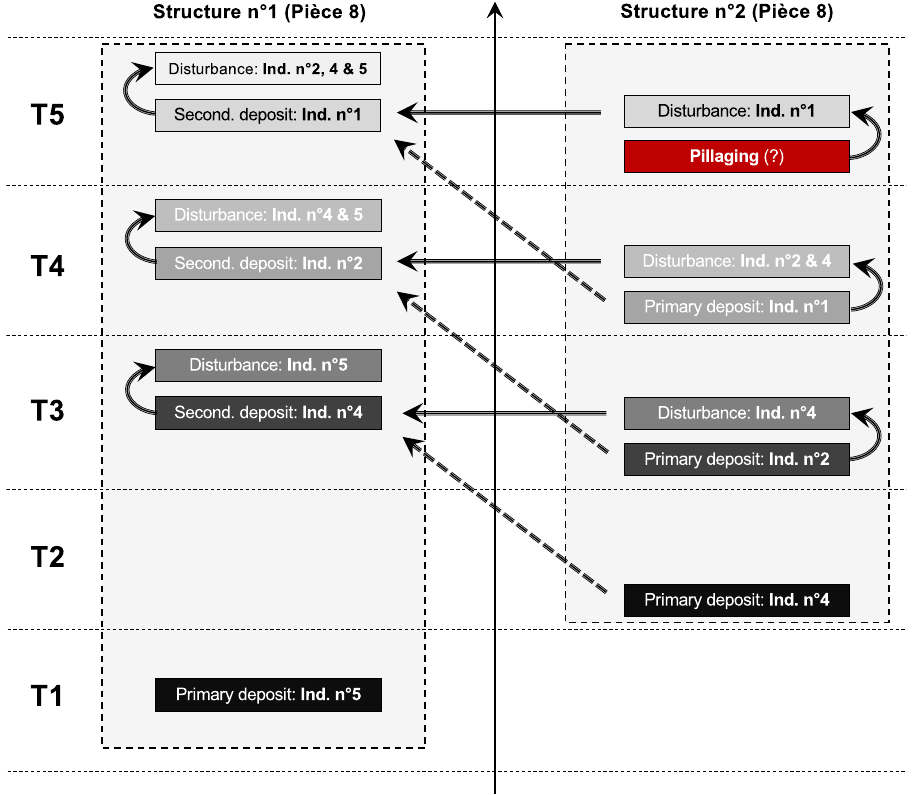
Figure 10: Schematic graphic restitution of bone movement and individual disturbances within Structure no 1 and 2 ( Pièce 8 ) . Figure by Hofstetter ( 2016 )